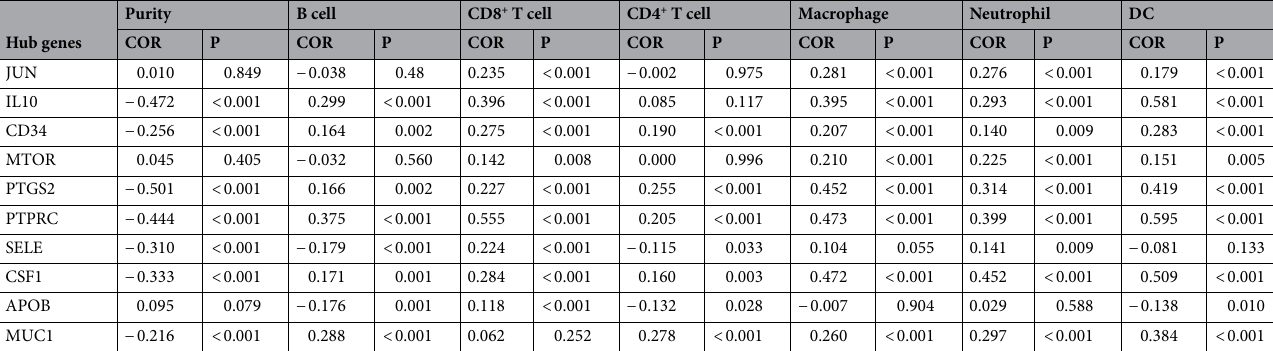
Table 3. Correlation analysis between candidate hub genes and immune cells in the TIMER2.0